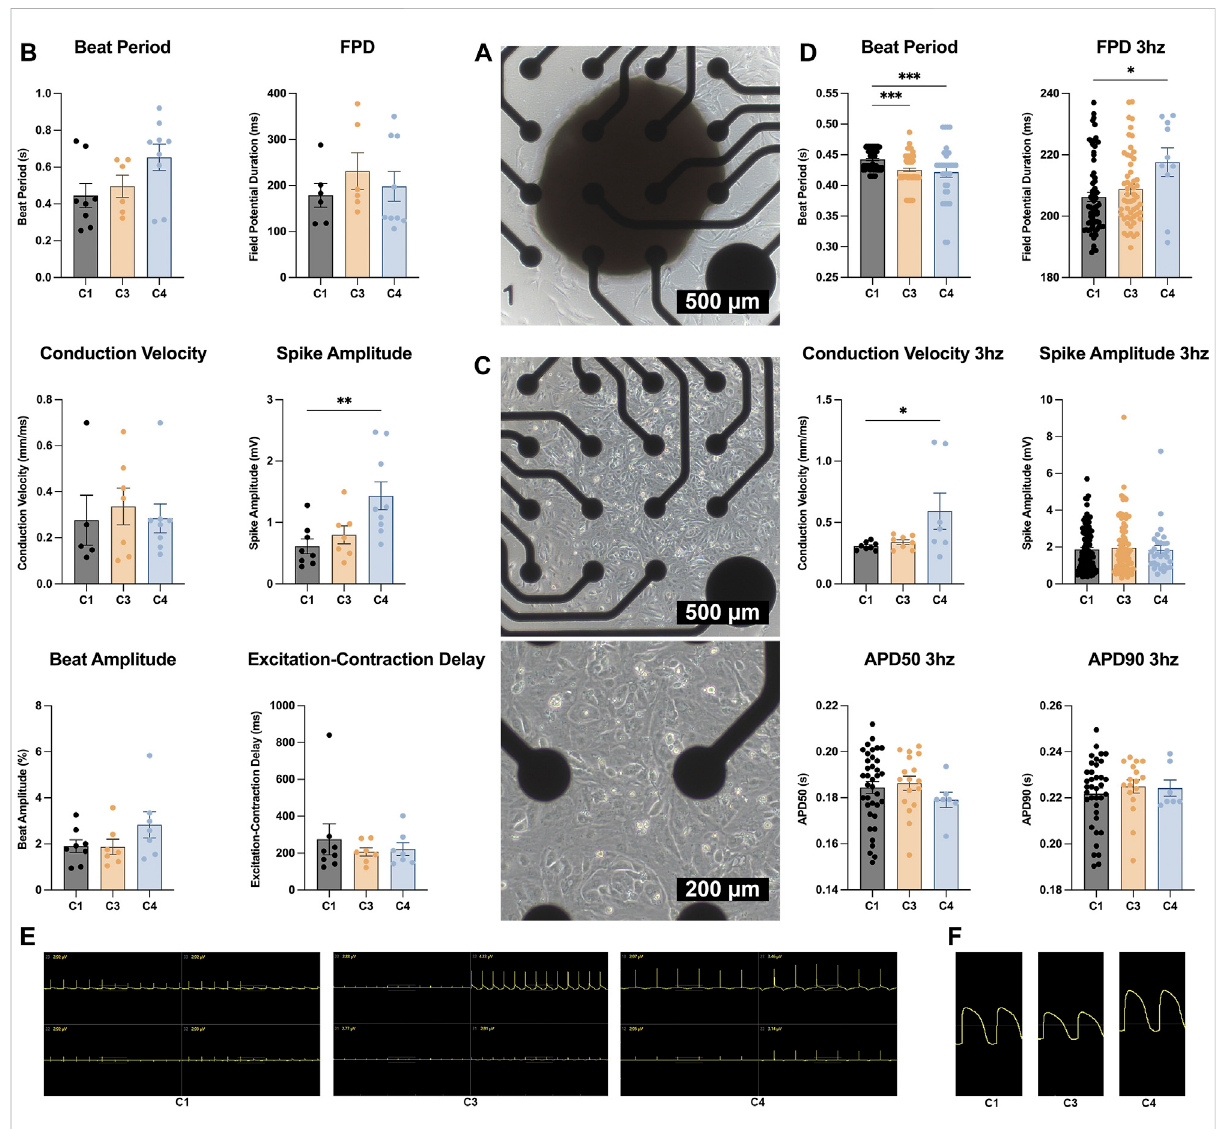
FIGURE 7 MEA assessments. (A) Whole C1, C3, and C4 spheroids (C1 black; C3 yellow; C4 blue) were attached to a 4 × 4 MEA; then, fi eld potentials and impedanceweremeasuredandusedtocalculate (B) beatperiod,spikeamplitude, fi eldpotentialduration(FPD),conductionvelocity,beatamplitude, andexcitation. (C) C1,C3,andC4spheroids(C1black;C3yellow;C4blue)weredissociatedonD30;then,CMswerecollectedandplatedontheMEA electrodes. Fieldpotentialsand impedanceweremeasuredwithandwithoutpacing at3 hz(330 msor180 bpm) andusedtocalculate (D) beat period, spike amplitude, FPD, conduction velocity, and the action potential duration until 50and 90% recovery (APD50 and APD90), respectively. (E) MEA fi eldpotentialtracesforC1,C3,andC4wholeorganoidsonlyshowingthe4electrodesthatwereusedforanalysis. (F) MEA fi eldpotentialtraces of dissociated C1, C3, and C4 organoids after undergoing LEAP induction (* p < 0.05, ** p < 0.01, *** p < 0.001; n > 6 per